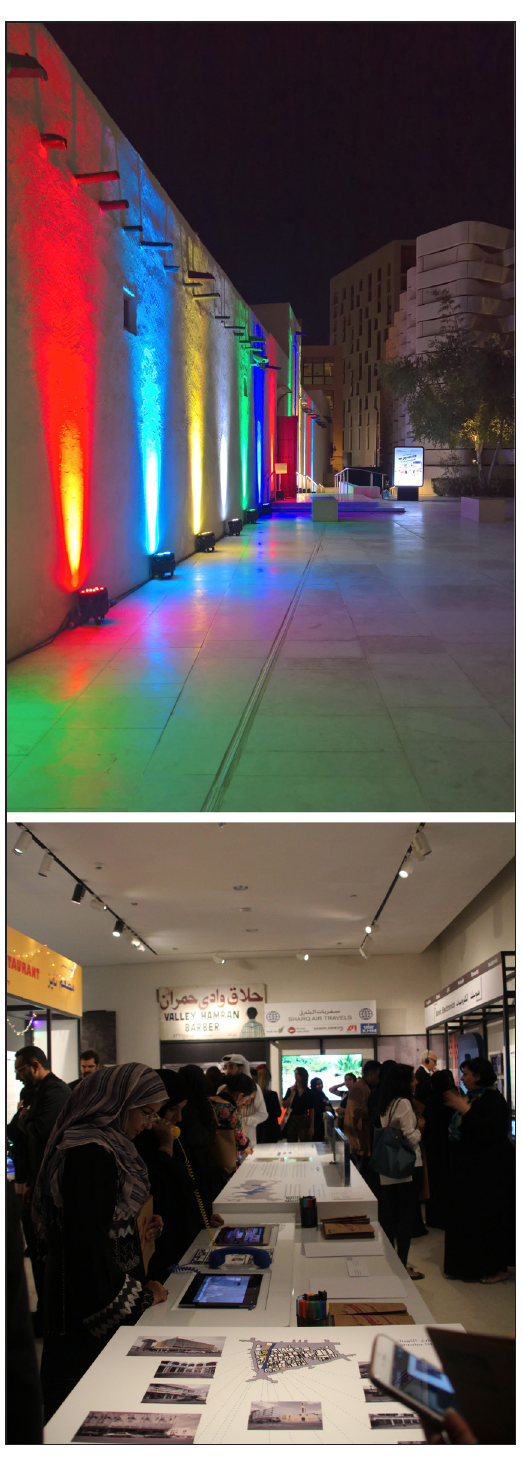
Figure 4: Msheireb Museum and UCL Qatar students’